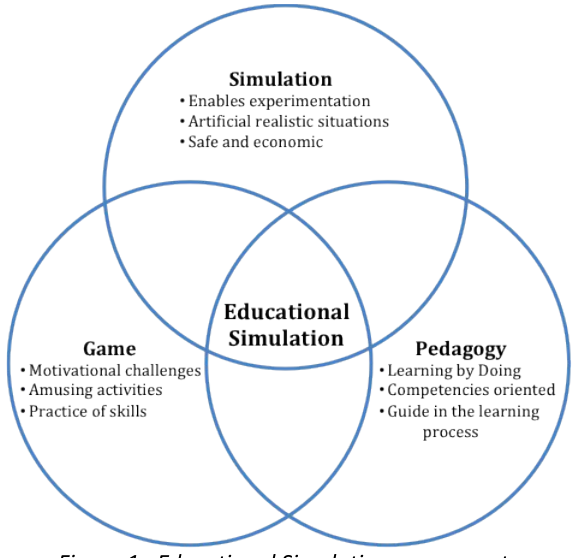
Figure 1. Educatonal Simulaton